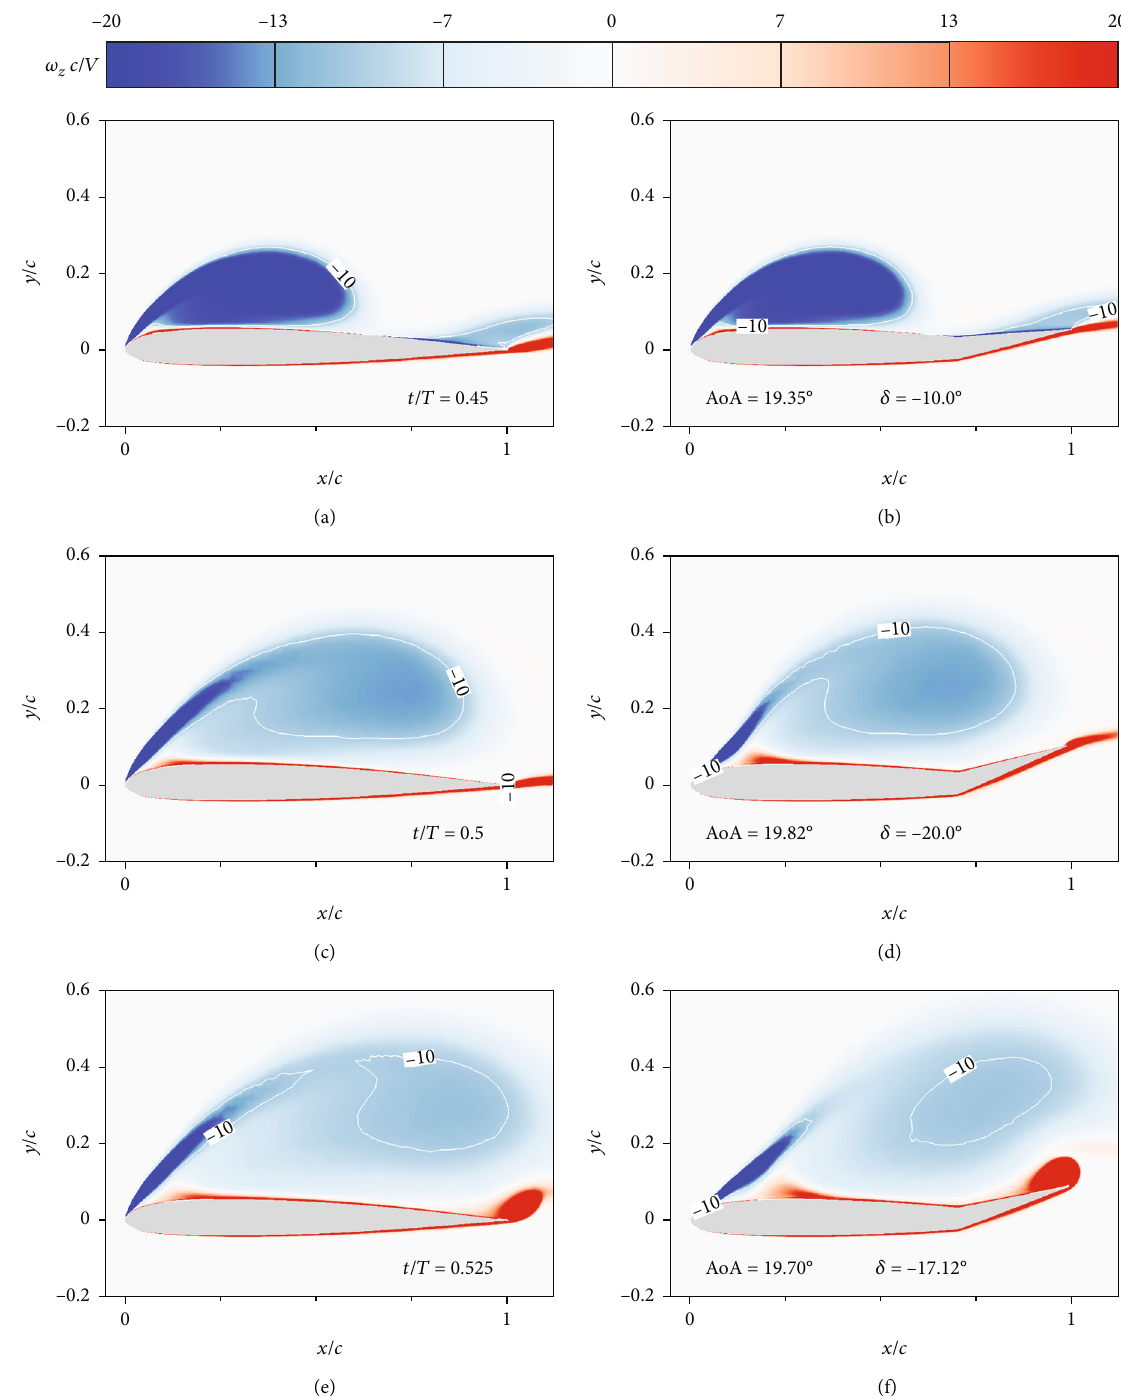
Figure 18: Normalized vorticity contours at di ff erent times during one pitching cycle for the two airfoils: (a, c, e) original airfoil and (b, d, f) TEF airfoil. The solid white line represents the contour line that the normalized vorticity is